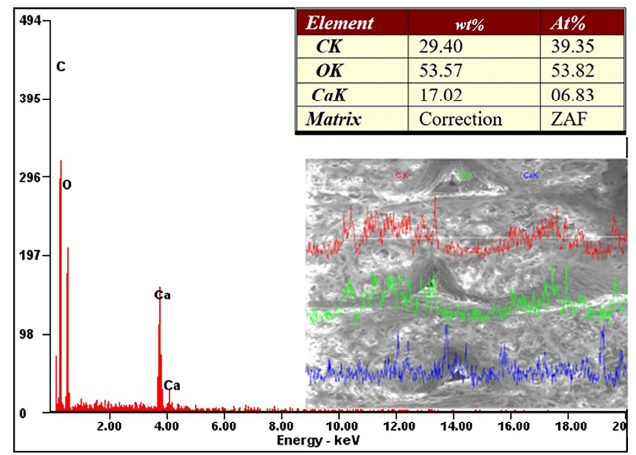
Figure 11. EDX spectroscopic analysis for the Extrudr BDP Flax material.